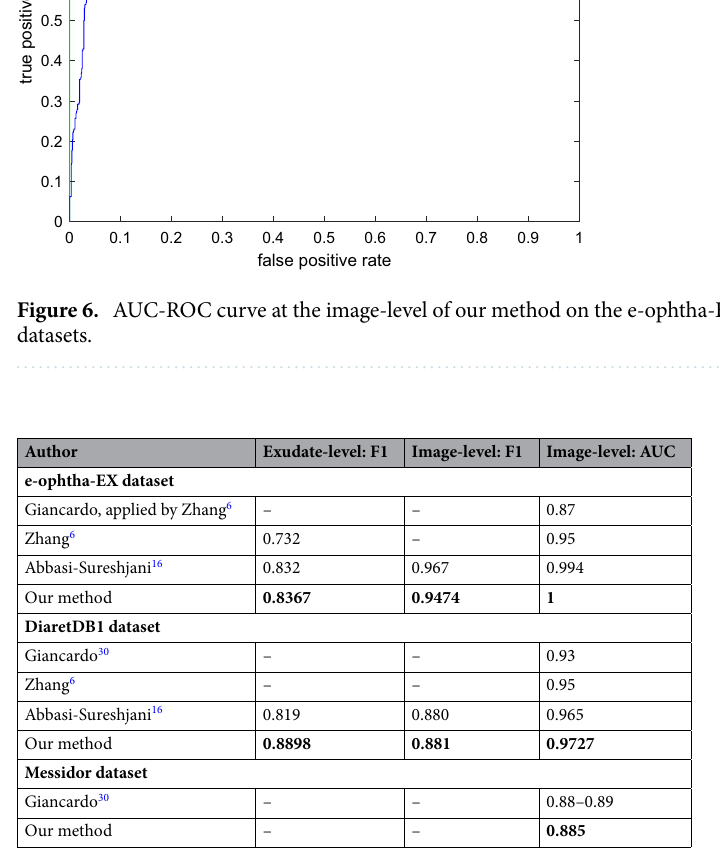
Table 2. Results of the proposed method, compared to other methods. Results of the proposed method are highlighted in bold.